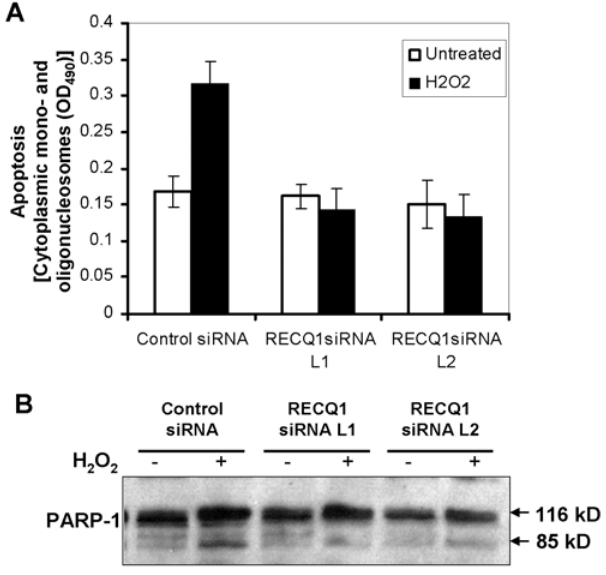
Figure 5. Effect of RECQ1 depletion on spontaneous or oxidative stress induced apoptosis. HeLa cells were siRNA treated for 48 h, and